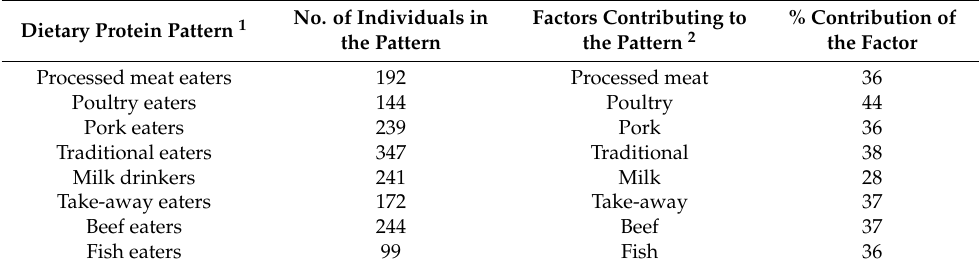
Table 3. Dietary protein patterns identified from the scores of individuals from the INCA2 study ( n = 1678) for the different